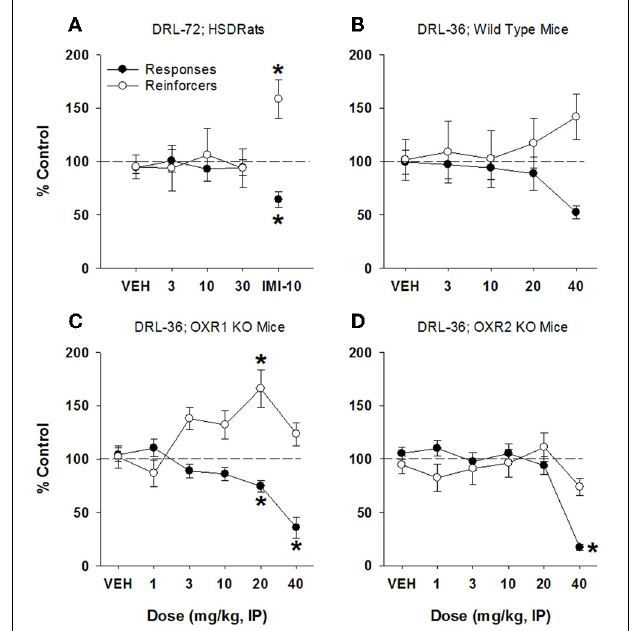
FIGURE 4 | SB334867 failed to produce antidepressant-like effects in rat DRL-72-s or mouse DRL-36-s. (A) SB334867 did not affect total responses or reinforcers received in male SD rats maintained on a DRL-72-s schedule of responding within a dose range of 3–30mg/kg ( n = 7). Importantly, the positive control, imipramine, did produce an antidepressant-like effect in this experiment at 10mg/kg; (B) no significant effect of SB334867 was observed on total responses emitted or reinforcers received in C57Bl/6 mice ( n = 7); (C) significant decrease in total responses emitted by mice lacking OX1 receptors at 20 and 40mg/kg ( p < 0 . 01), with a concomitant increase in reinforcers received at 20mg/kg ( p < 0 . 01; n = 8); (D) significant decrease in total responses emitted ( p < 0 . 05) without a concomitant increase in reinforcers received, by mice lacking OX2 receptors, at 40mg/kg ( n = 8). ∗ p < 0 . 05 vs. respective vehicle, Dunnett’s post-hoc